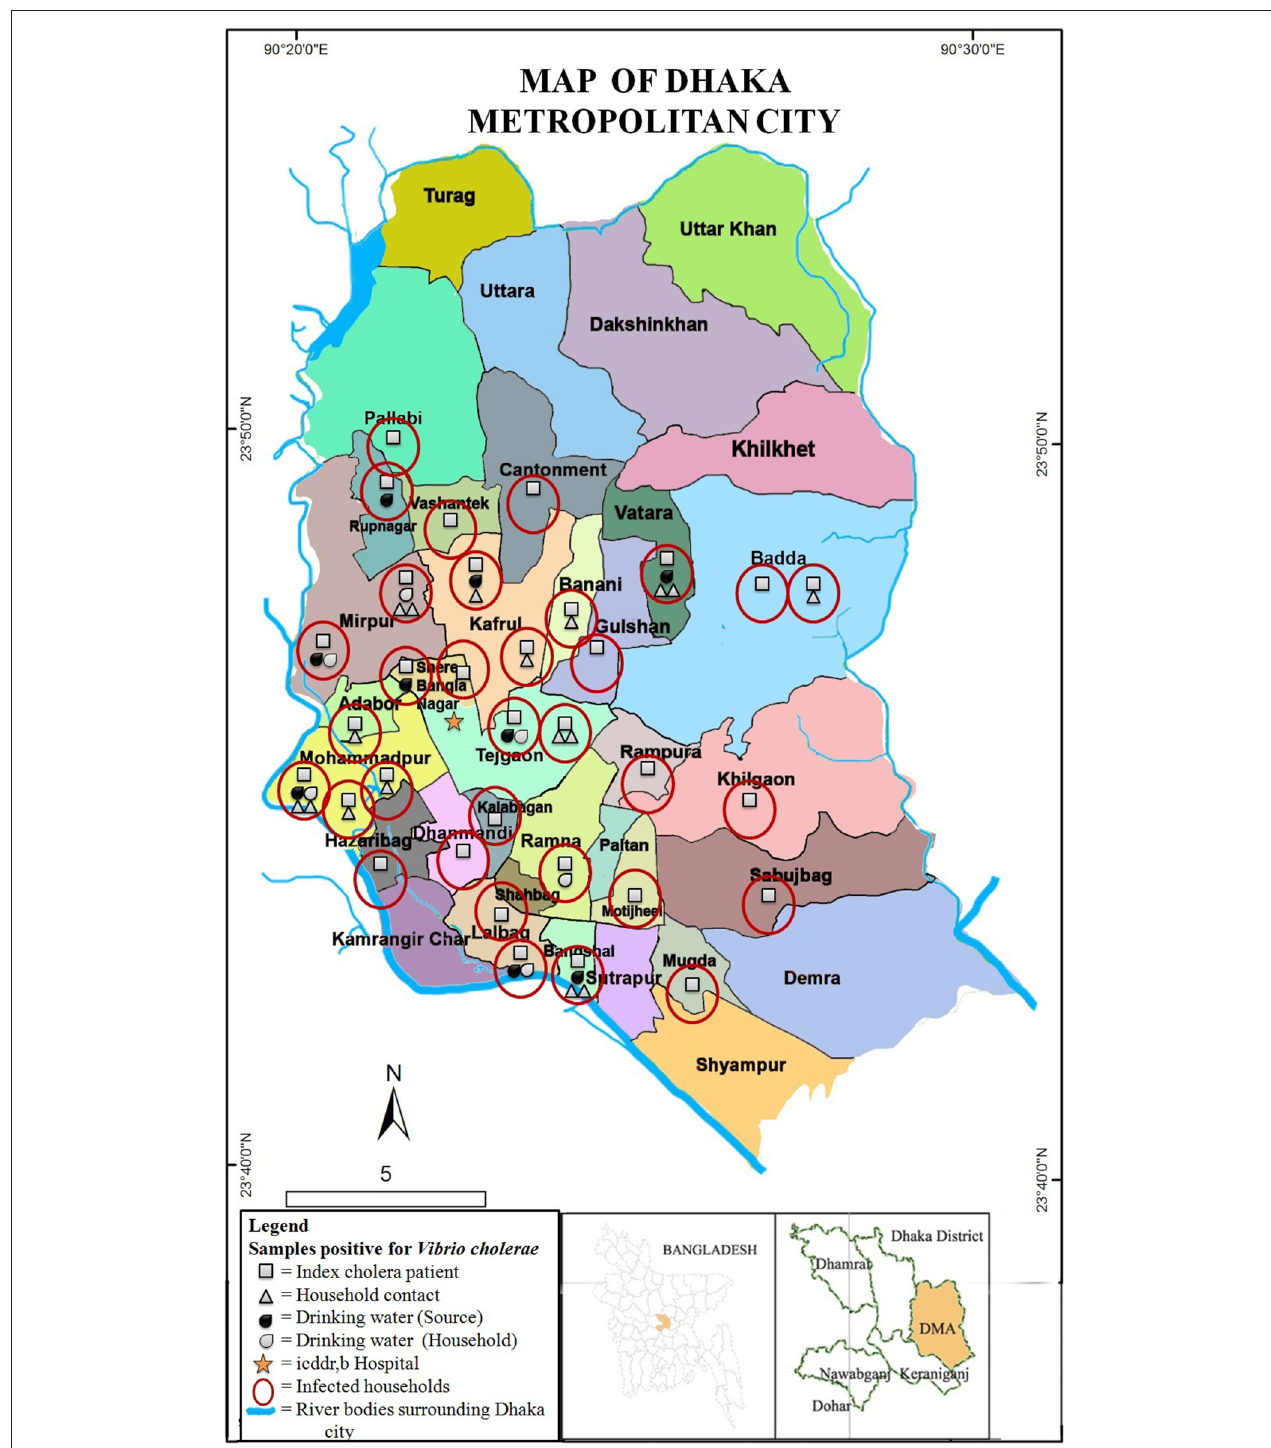
FIGURE 1 | Map showing distribution of households with Vibrio cholerae O1 strains isolated from hospitalized cholera patients, their household members, and drinking water sources in different police stations of Dhaka city. Drinking water samples from both source and household storage were included. All samples were collected from 33 households of cholera patients, distributed across 25 police stations (thana) of the city.